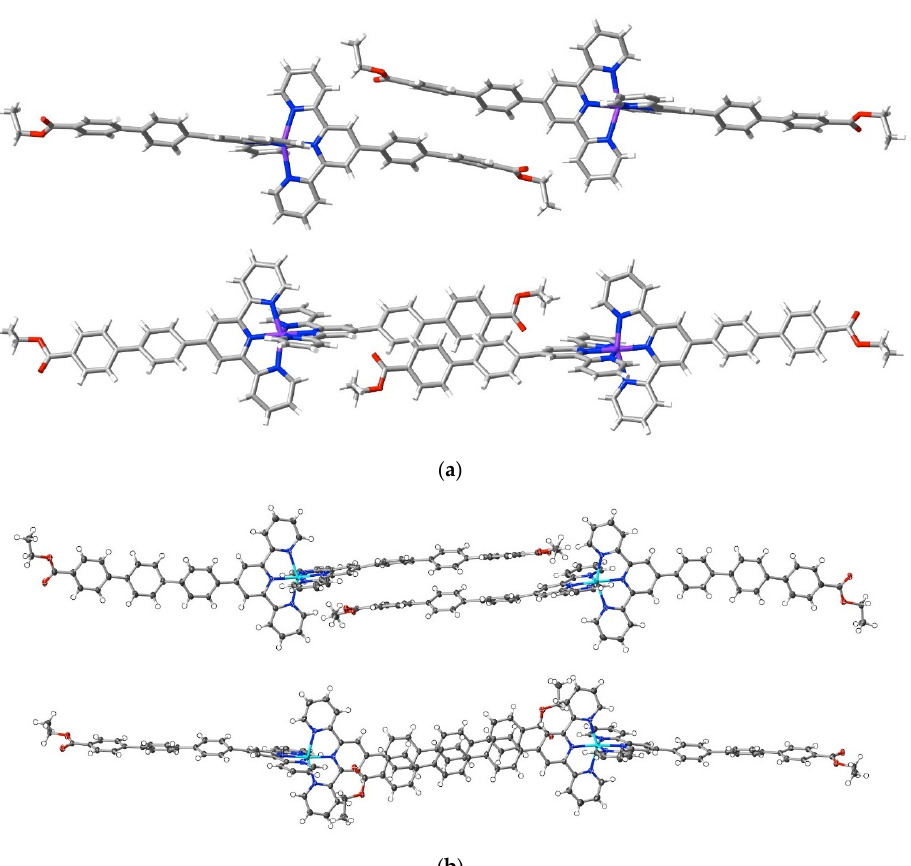
Figure 9. Effect of polyphenyl chain length on stacking arrays in complexes of ethoxycarbonylphenyl-substituted terpyridine complexes. Orthogonal views of proximal arms in ( a ) [Cu( ebptpy ) 2 ](ClO 4 ) 2 · CH 3 CN, 26 , and ( b ) [Zn( etptpy ) 2 ] (ClO 4 ) 2 · 2DMF · H 2 O, 27